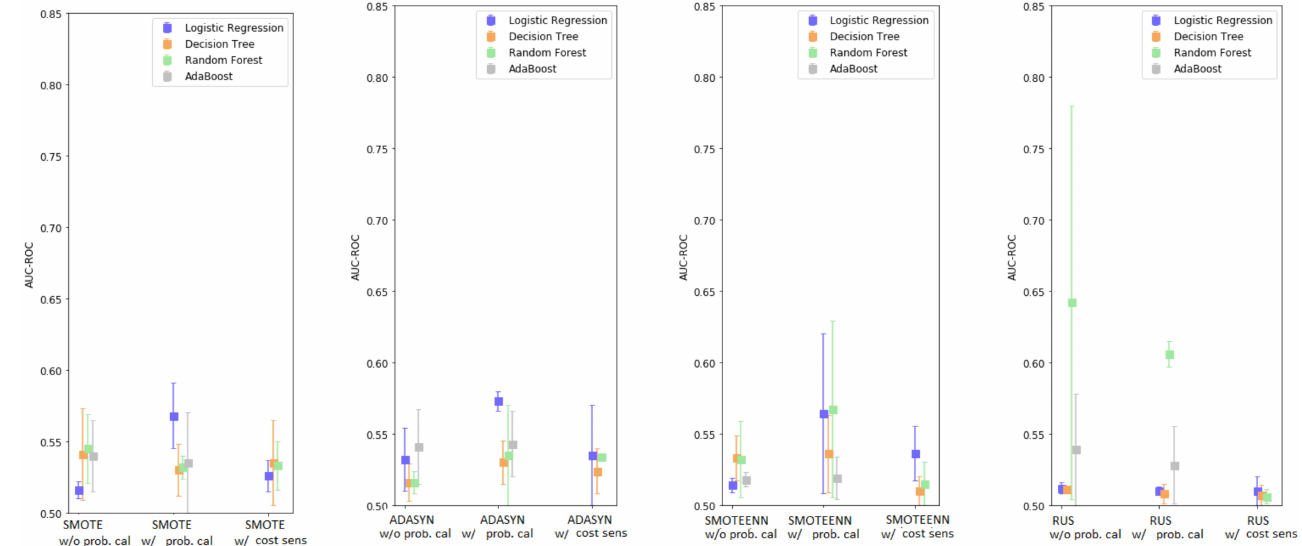
Figure 1. Enhanced base classifiers